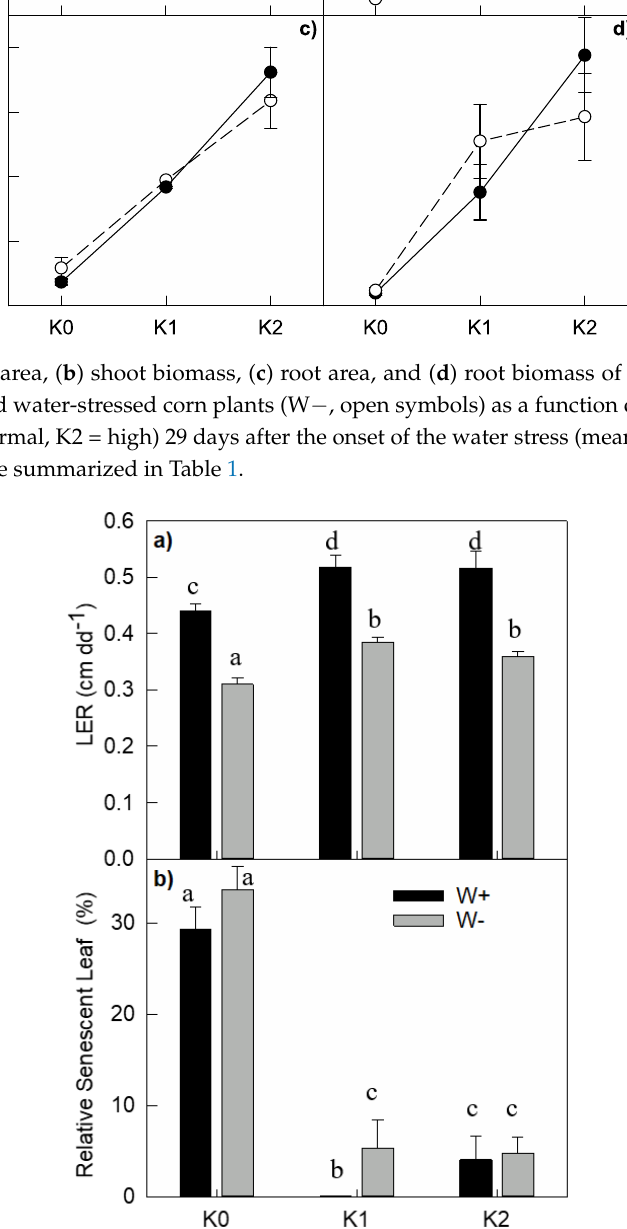
Figure 3. ( a ) Leaf elongation rate for leaf number 10 and ( b ) percent senescent leaf (relative to the total number of leaves) at the same development stage (10 visible leaves) of well-watered (W+, black bars) and water stressed (W − , grey bars) of corn plants as a function of three potassium levels (K0 = low, K1 = normal, K2 = high; mean ± Standard Error; n = 7). Senescence of K1W+ plants was equal to 0. Statistics are summarized in Table 1. Letters represent significant differences at 5%